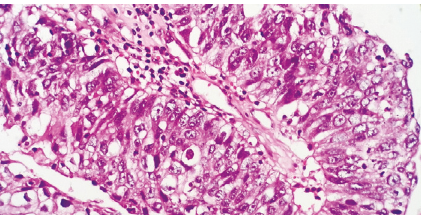
Figure 3: High power view of histomorphology of urothelial carcinoma (H&E 400X magnification).